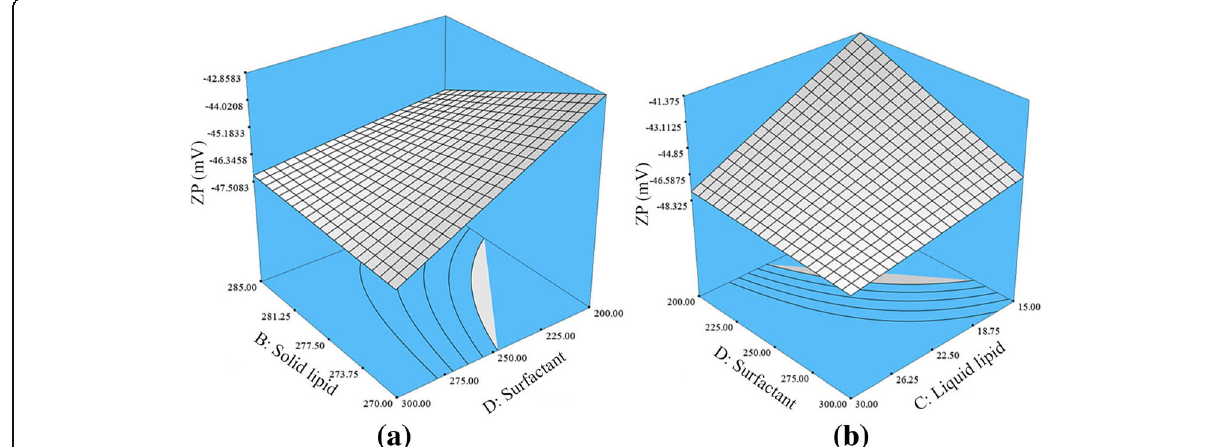
Fig. 4 Response surface plot depicting the significant ( p < 0.05) effect of liquid lipid concentration, surfactant concentration, and interactions between a BD and b CD on the ZP of HVD-NLCs. B solid lipid, C liquid lipid, D surfactant